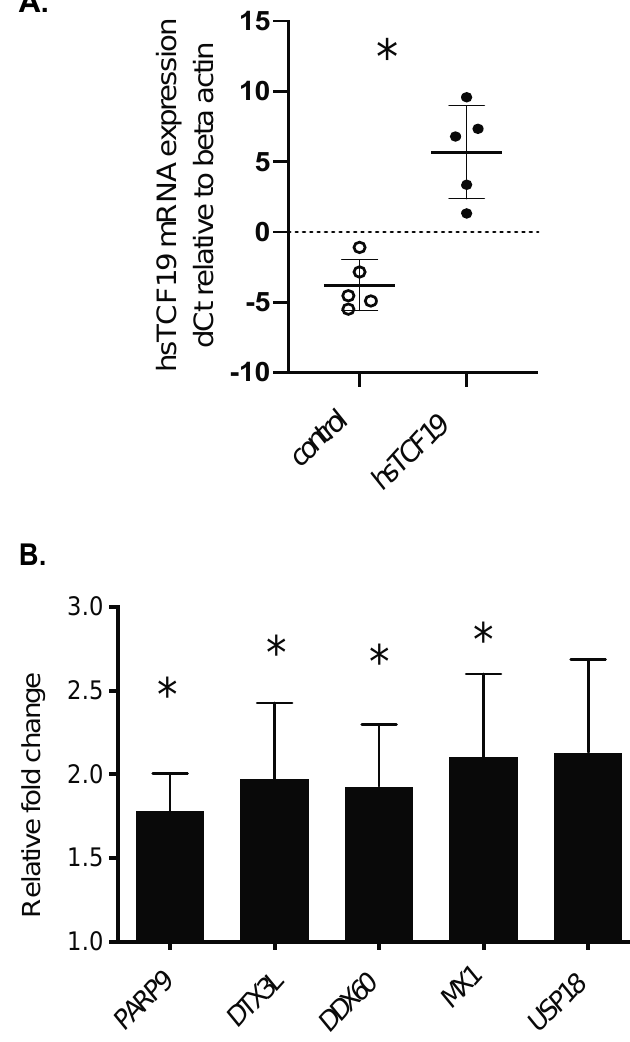
Figure 3. Human TCF19 overexpression in human islets upregulates key DNA damage repair genes as well as viral response genes. ( A ) hsTCF19 overexpression in human islets was confirmed with qRT-PCR. Control represents human islets transfected with an empty vector and hsTCF19 represents human islets transfected with TCF19 plasmid. ( B ) hsTCF19 overexpression in human islets leads to upregulation of genes (qRT-PCR) that were also upregulated in INS-1 cells (n = 5). Gene names are shown on the horizontal axis. Data are means ± SEM * p < 0.05.